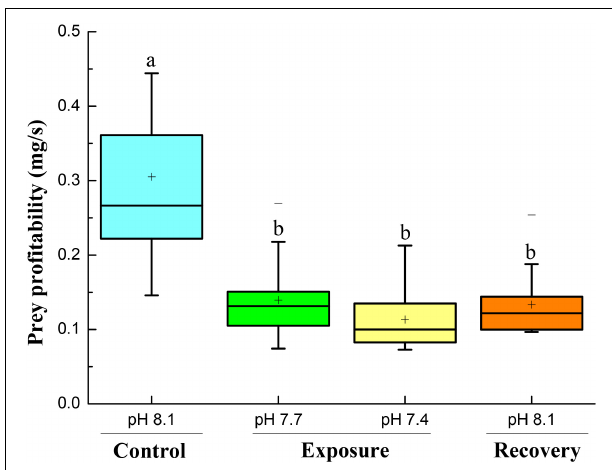
FIGURE 6 | Prey profitability of crabs at different pH conditions following four successive treatments. Values are means ± SE expressed as mg dry weight handling time − 1 crab − 1 . Different letters indicate significant differences between pH conditions ( P <